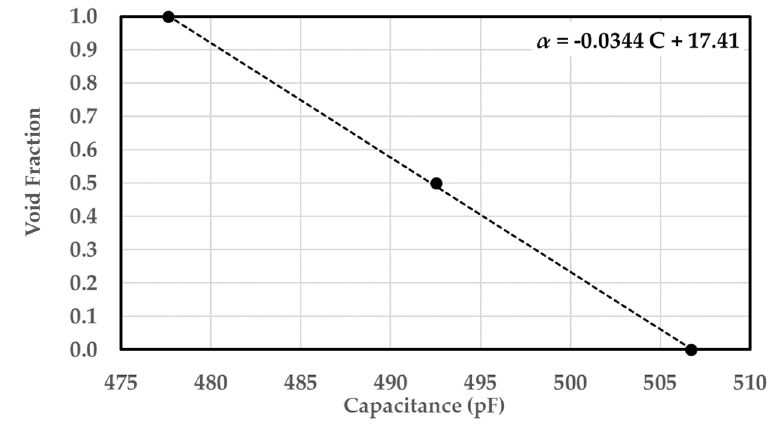
Figure 29. Calibration curve for air–castor oil conditions.